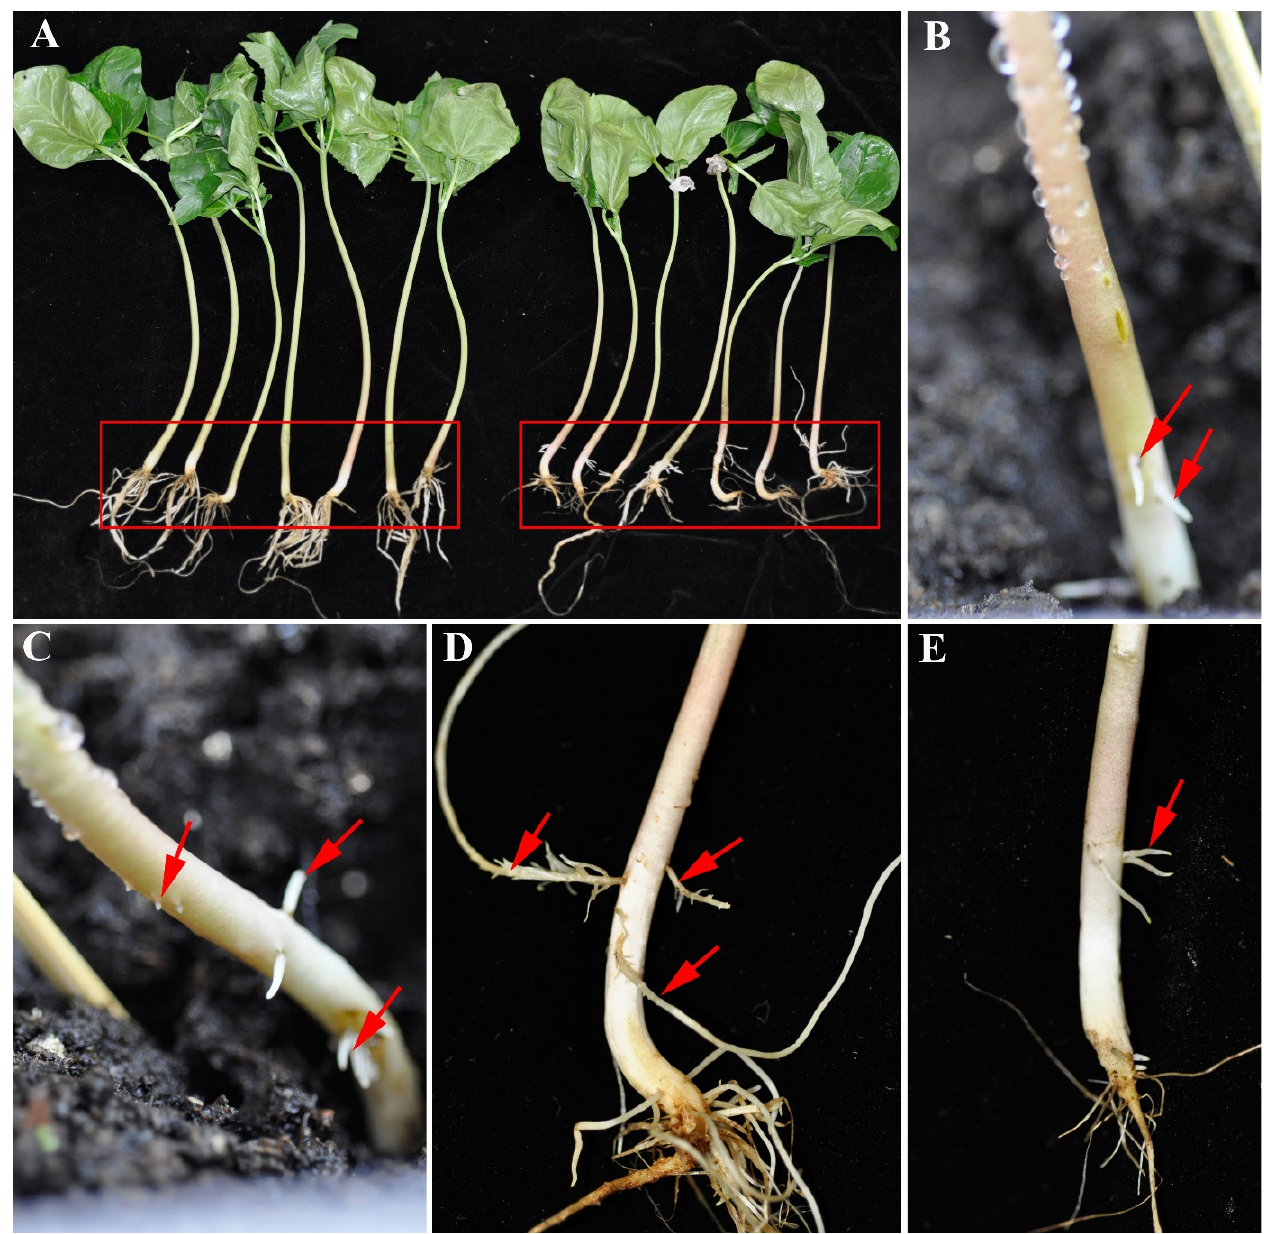
Figure 3. Induction of hairy roots in the stem of castor by the modified method shown in Figure 1. ( A ) Castor seedlings with or without hairy roots 4 weeks after injection. (The red boxes indicate the stem region). ( B – E ) Hairy roots that formed on the stem of different seedlings of castor, as a result of inoculation. All the hairy roots arose directly from the epidermis of the stem. Few calli were observed. The arrows indicate the induced hairy roots.